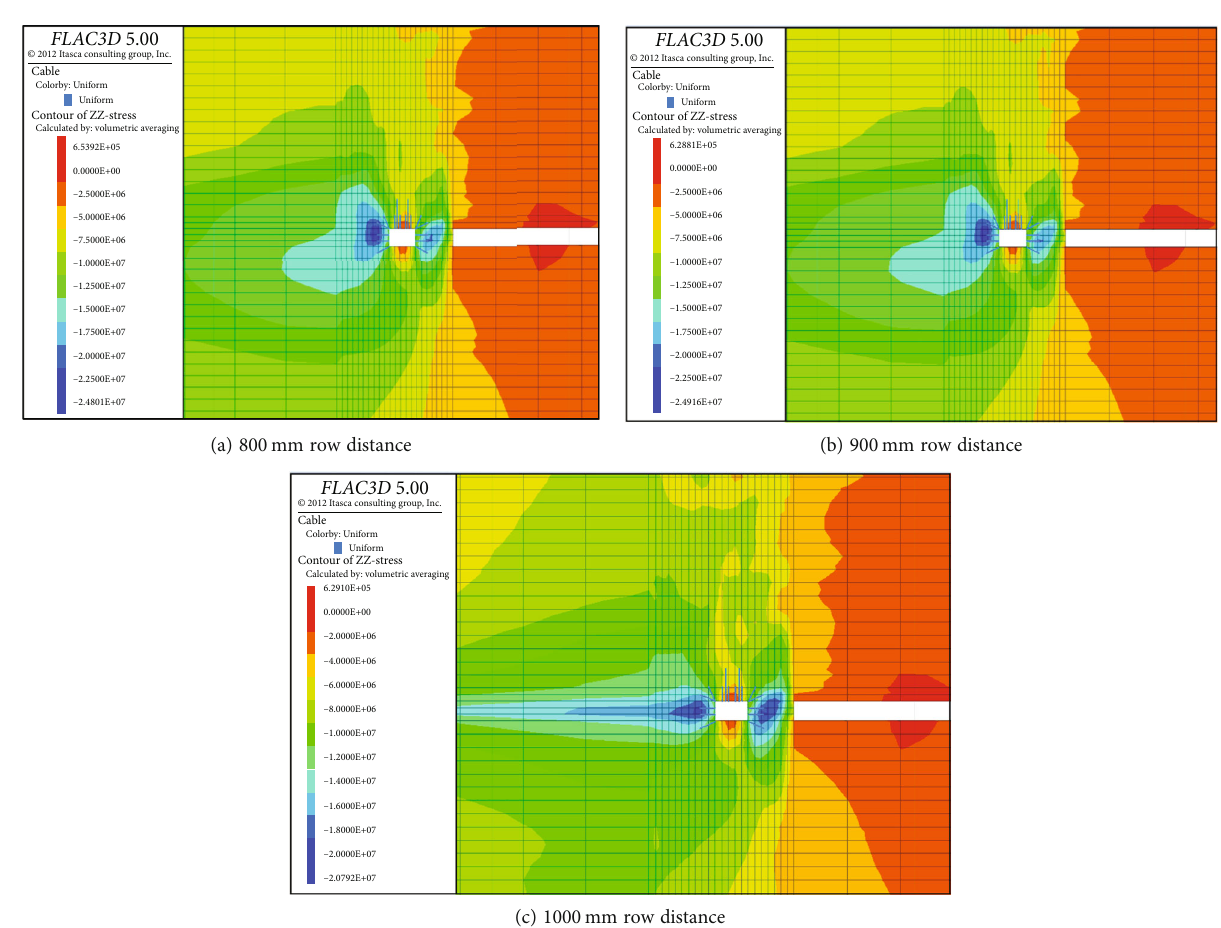
Figure 10: Vertical stress distribution in 7m width coal pillar and surrounding rock of roadway along goaf under the condition of di ff erent bolt (cable) support row